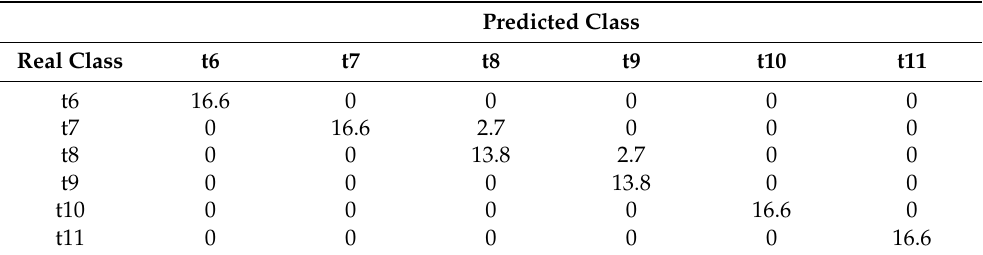
Table 2. Confusion matrix obtained through PLS-DA for roasted coffee beans submitted to different thermal treatments (t6–t11). Values are expressed in percentages of the samples